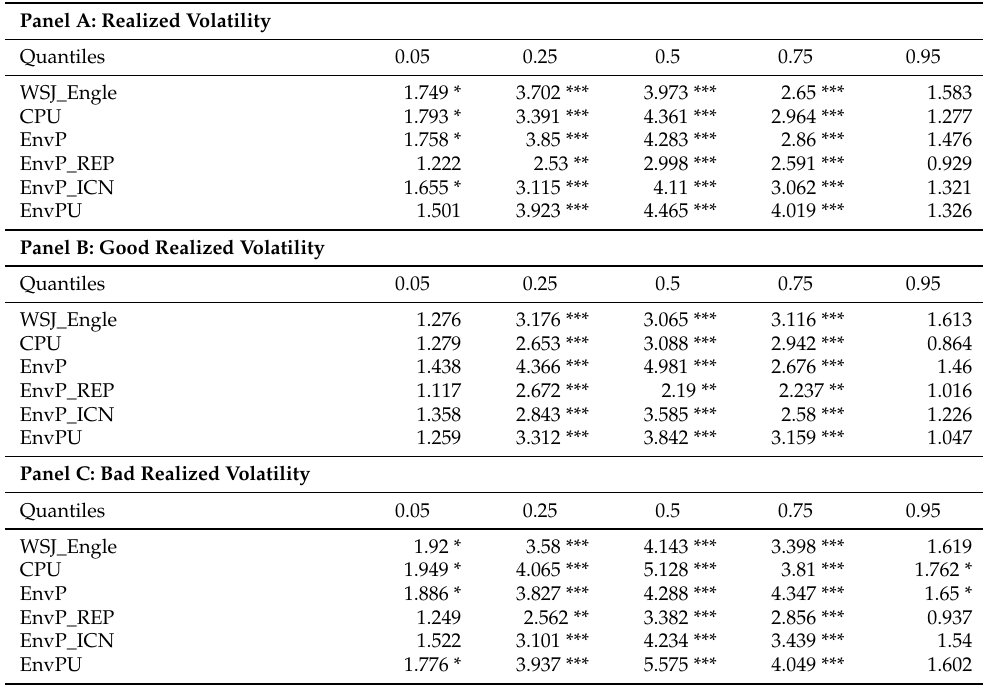
Table A8. Causality-in-quantiles results of various US climate risks on the realized volatility of South